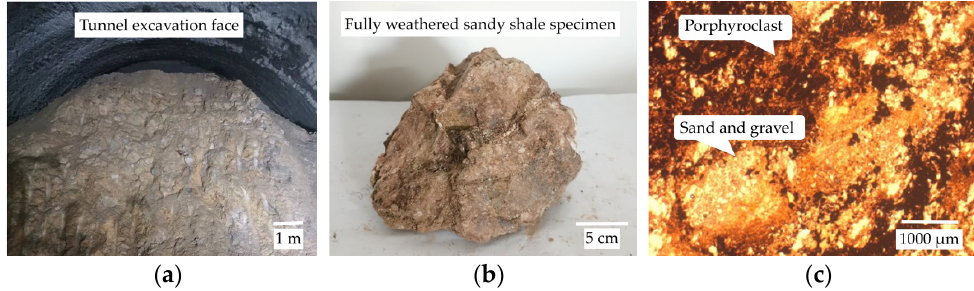
Figure 1. Images of fully weathered sandy shale. ( a ) Fully weathered sandy shale in situ, ( b ) a specimen in the lab and ( c ) the lamellar texture under a microscope.